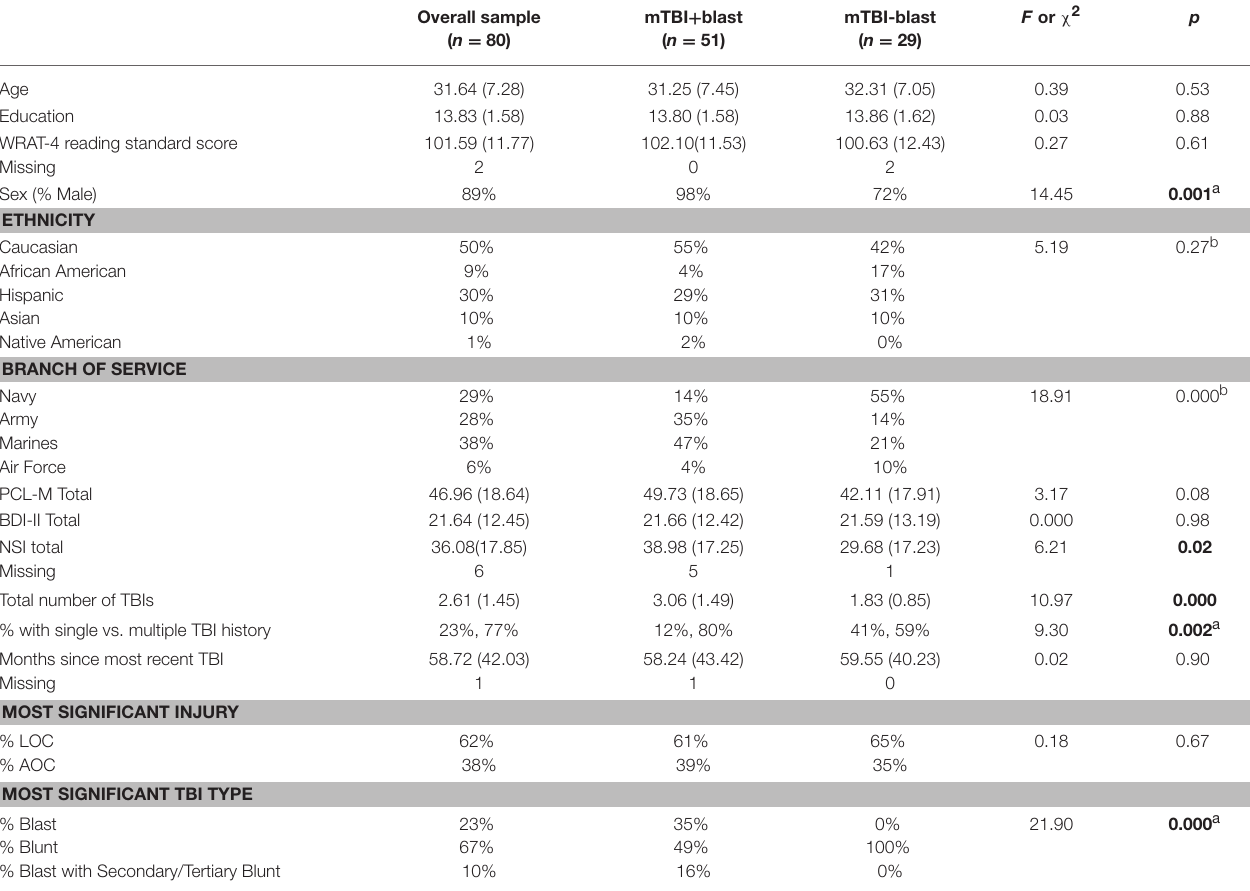
TABLE 1 | Sample characteristics, mean